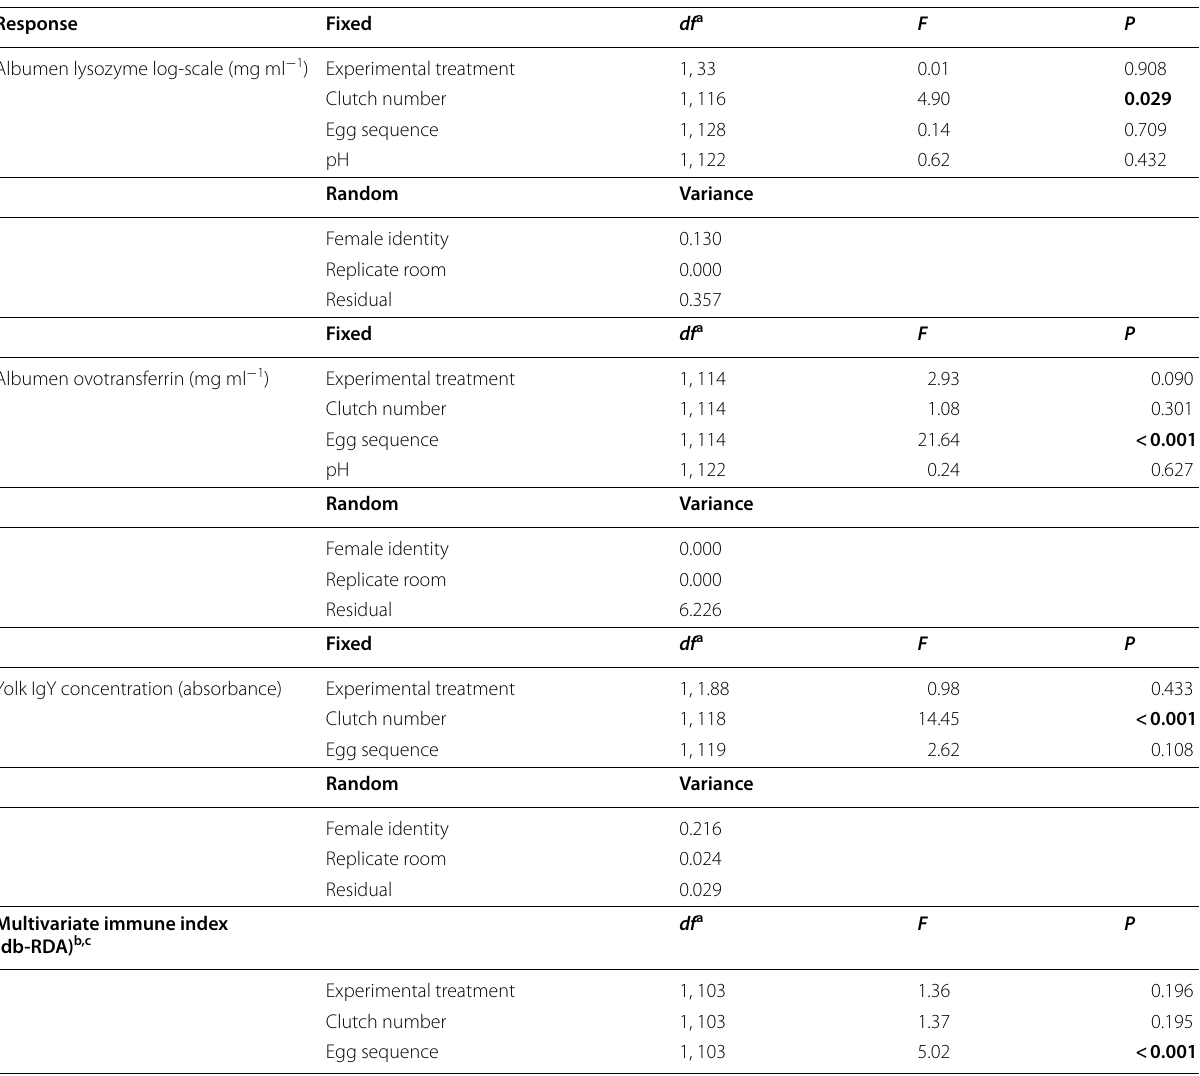
Table 1 Analysis of variance of egg immune function